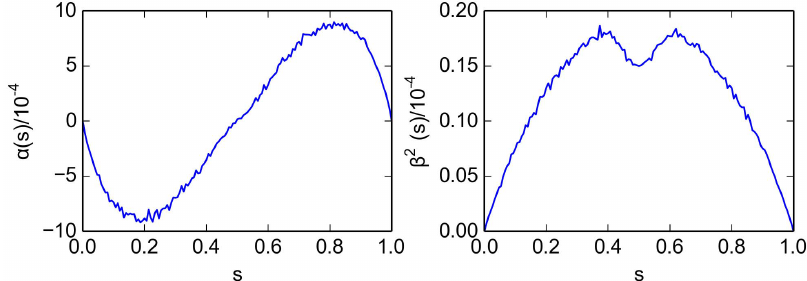
Figure 1. Parameters a ( s ) (left) and b 2 ( s ) (right) for the stochastic differential equation as inferred from the simulation results for the virtual swarm. Simulation parameters are given in Table 1.